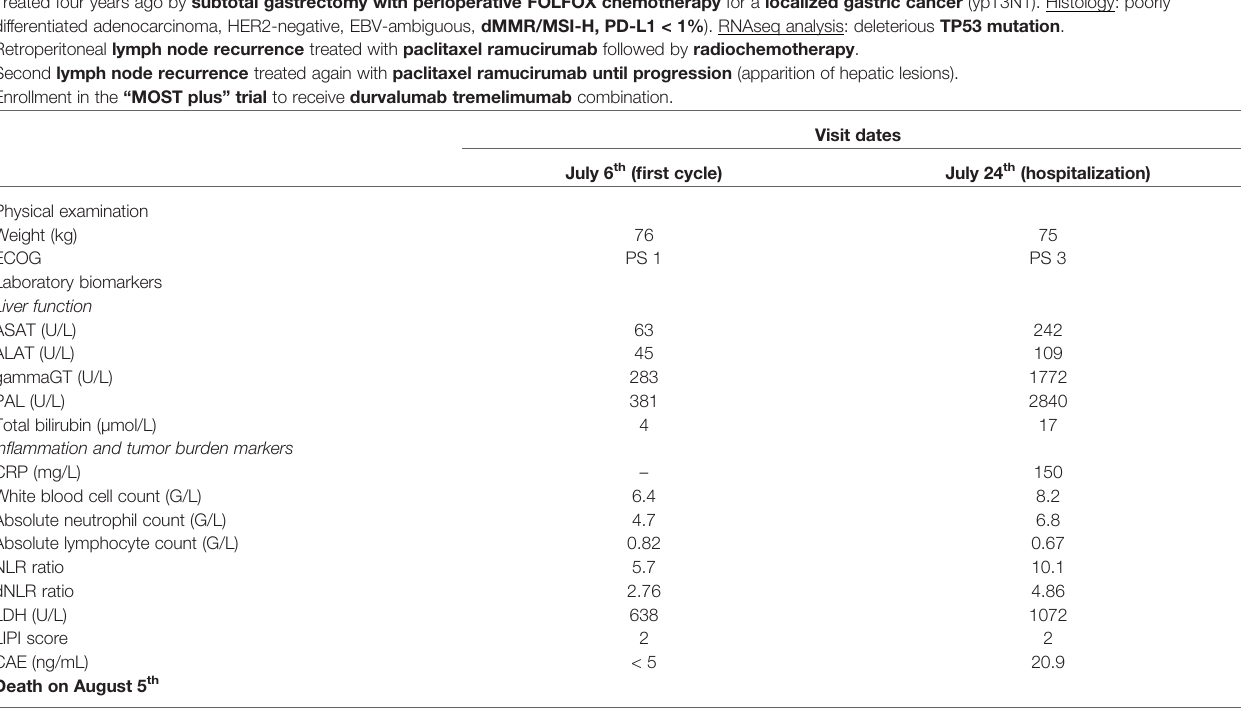
TABLE 2 | Chronological evolution of clinical and biological parameters. Relevant Past Medical History and Interventions 68 years old Caucasian patient without signi fi cant comorbidity. Treated four years ago by subtotal gastrectomy with perioperative FOLFOX chemotherapy for a localized gastric cancer (ypT3N1). Histology: